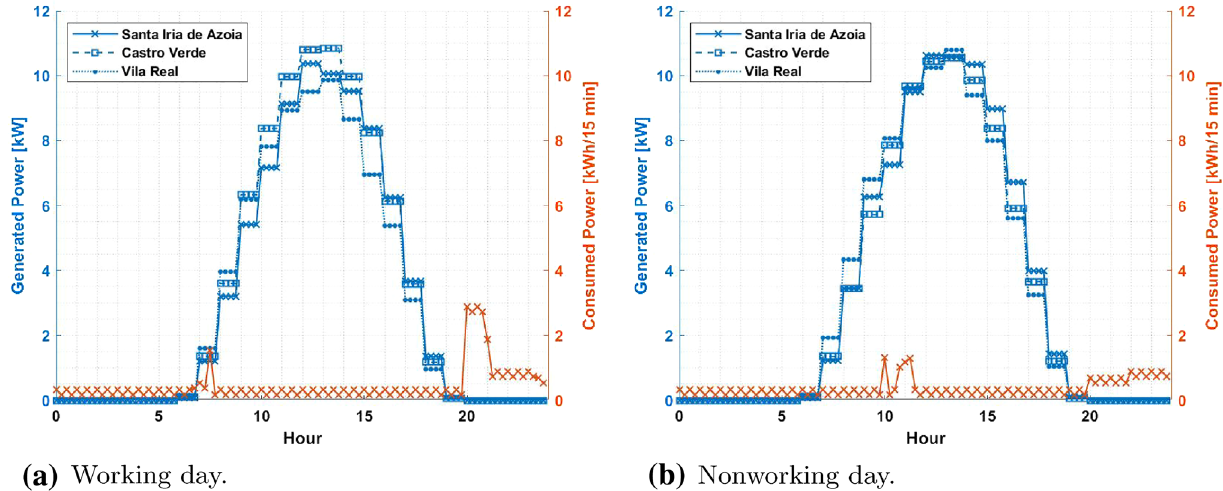
Fig. 12 Generation and consumption curves on the two significant days of August for c-Si